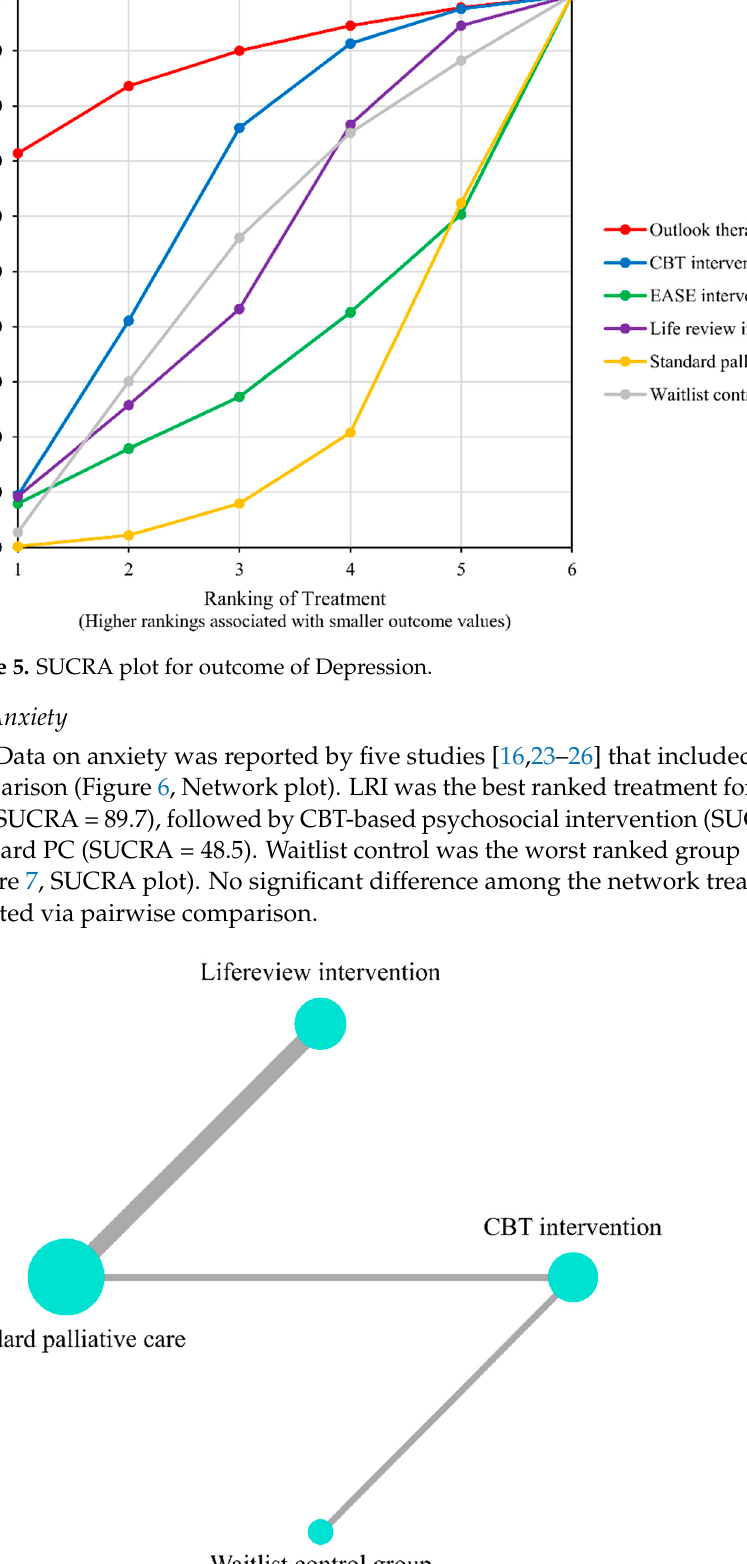
Figure 4. Network plot for outcome of Depression.